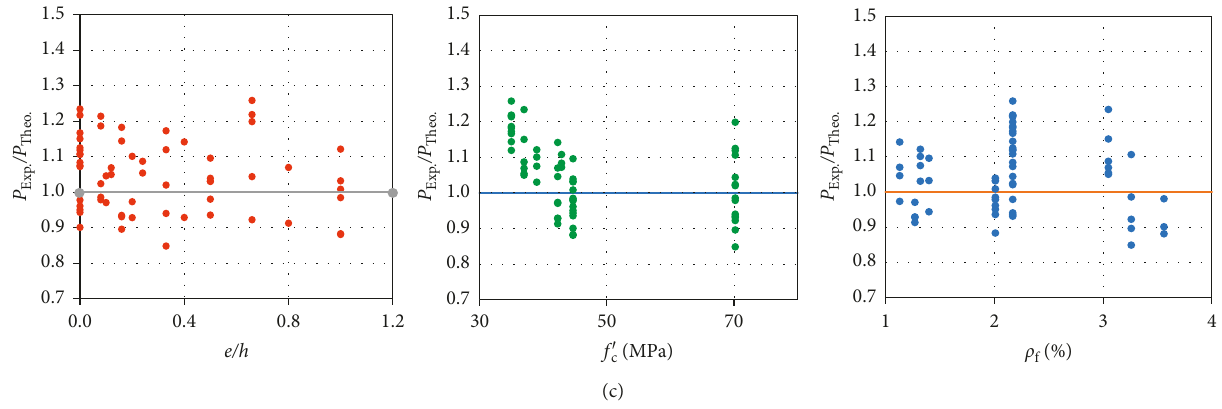
Figure 10: Effect of e / h , f , and ρ f on the test results. (a) ACI 440.1R-15. (b) Hadi et al. [18]. (c) c ′